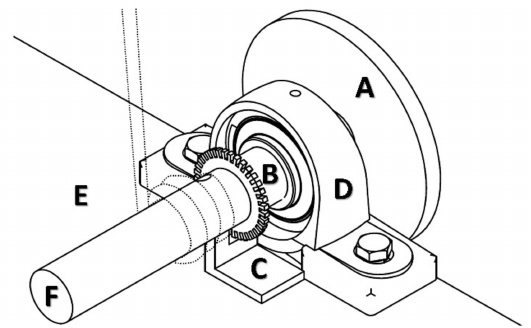
Figure 2. Technical drawing of the shaft-based sensor. ( A ) flywheel (FW); ( B ) a custom-made sprocket-wheel profiled with 50 teeth that interact with optocoupler photocell sensor ( C ); ( D ) block bearings; ( F ) rotating shaft with 30 mm diameter ( E ) standing platform; the dashed line represents a pulling rope wrapped twice longitudinally around the shaft, enabling a constant wrapping radius. In the concentric part of the squat, the athlete accelerates the FW into a spinning motion by unwinding the rope and, in contrast, the spinning motion of the FW is slowed down and stopped by winding the rope around the shaft in the eccentric part of the